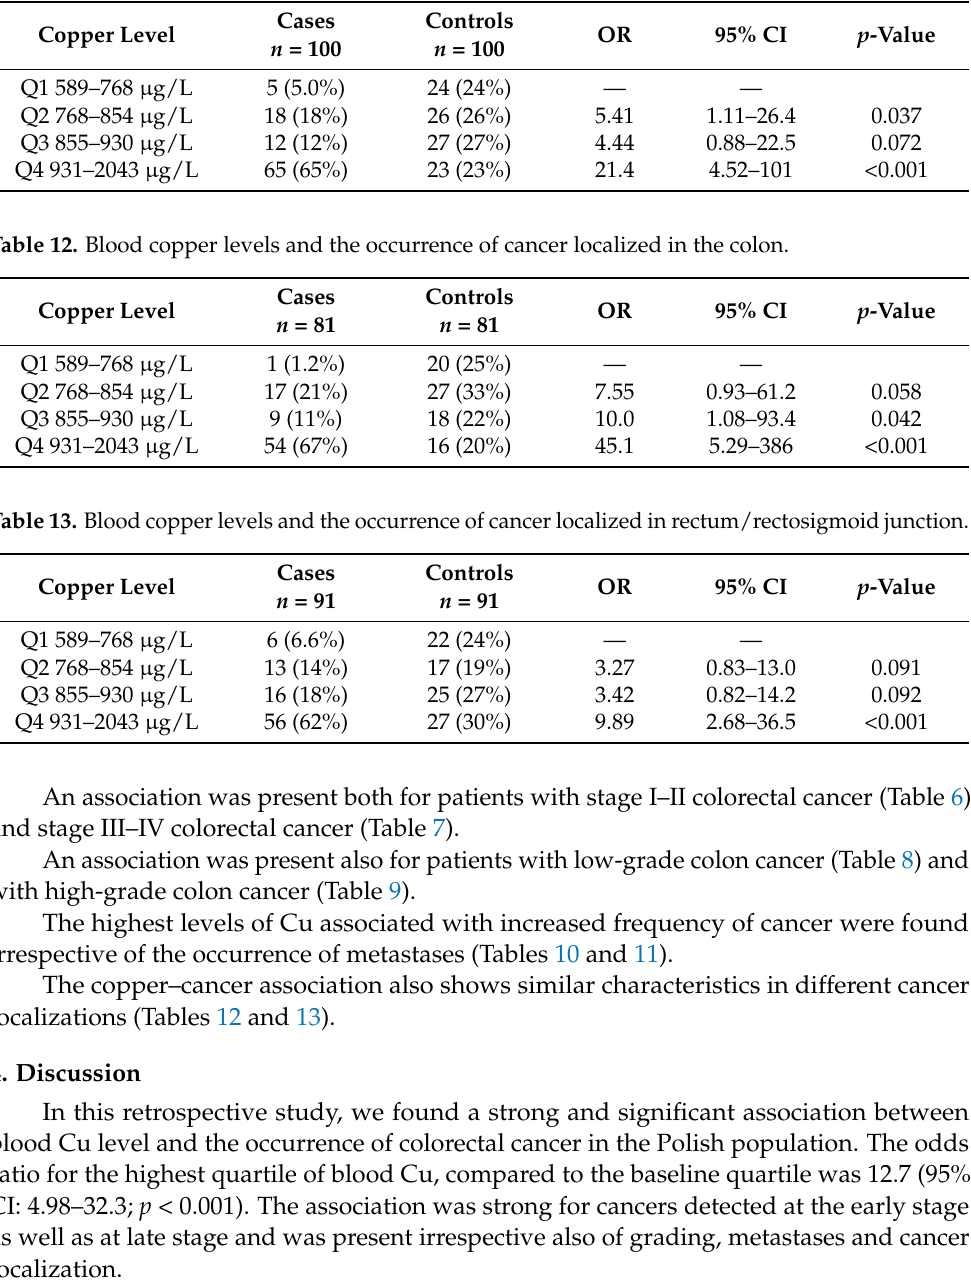
Table 11. Blood copper levels and the occurrence of colorectal cancer among patients without metastases.